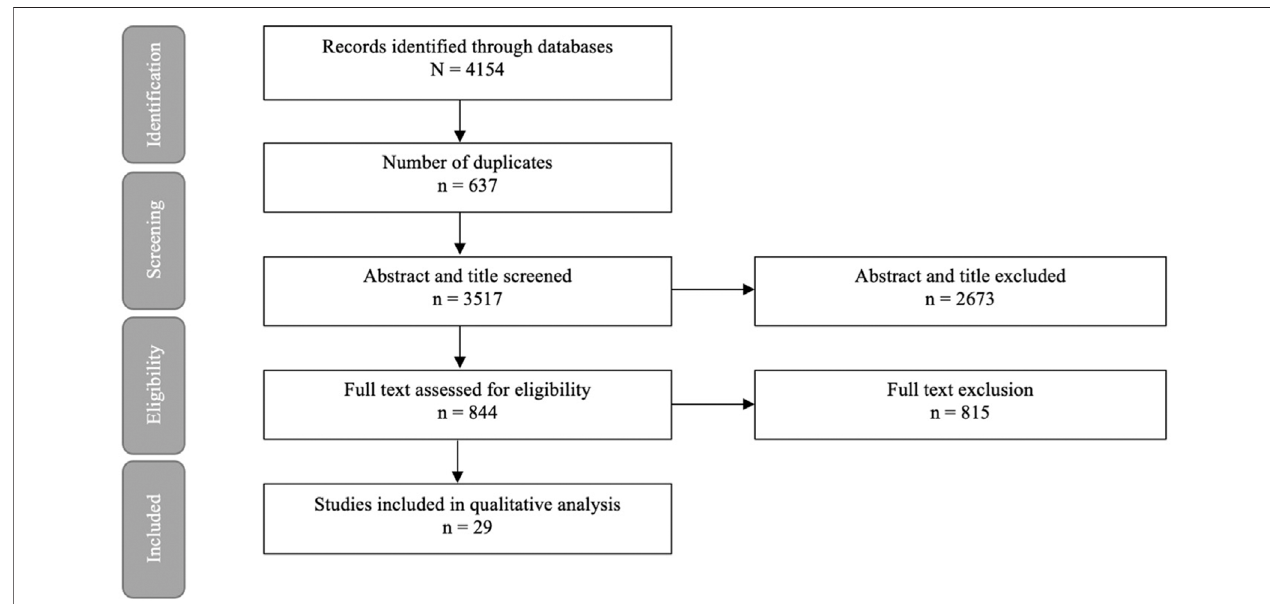
FIGURE 1 | Article selection